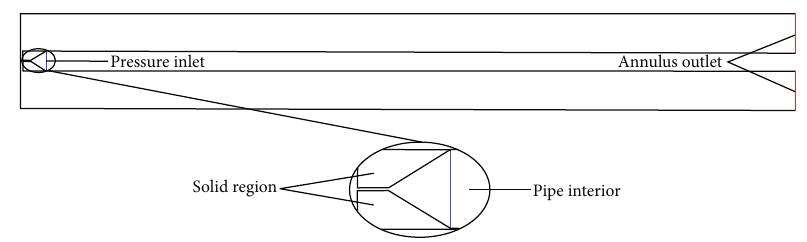
Figure 6: Geometric model of moving